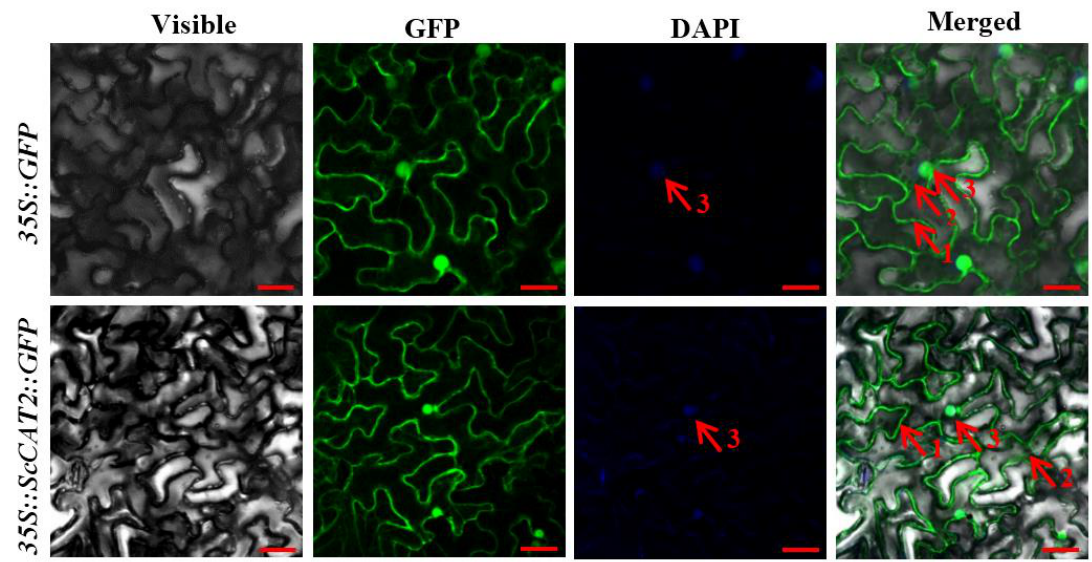
Figure 4. Subcellular localization of ScCAT2 and empty vector in Nicotiana benthamiana leaves after 2 days of infiltration. Images of epidermal cells captured using visible light, green fluorescence, blue fluorescence, and merged light. Red arrows 1, 2, and 3, indicated the plasma membrane, cytoplasm, and nucleus, respectively. Bar = 20 μm. DAPI (4 ′ ,6-diamidino-2-phenylindole) was used to stain the nucleus.